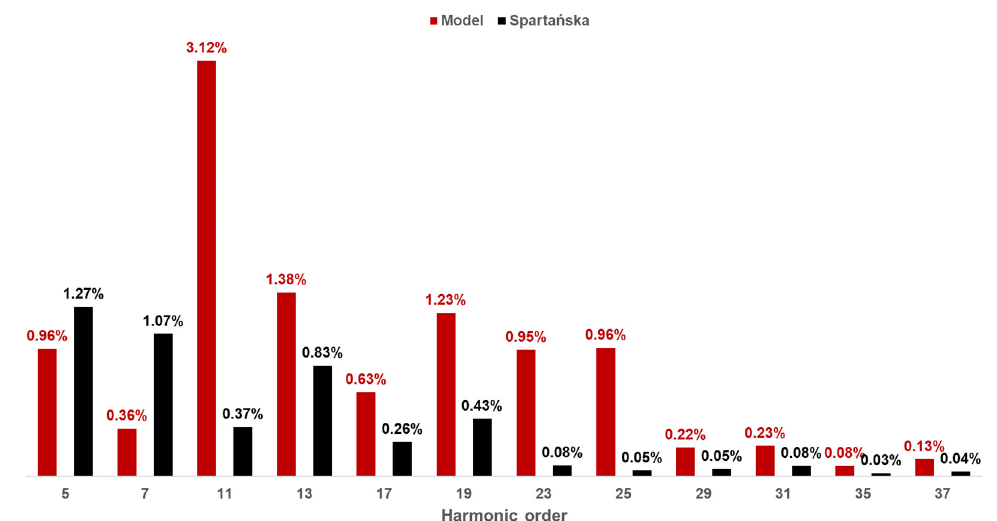
Figure 7. Voltage harmonic spectrum on the Sparta ń ska charging station and on the PCC of the charger in the bus terminus model.